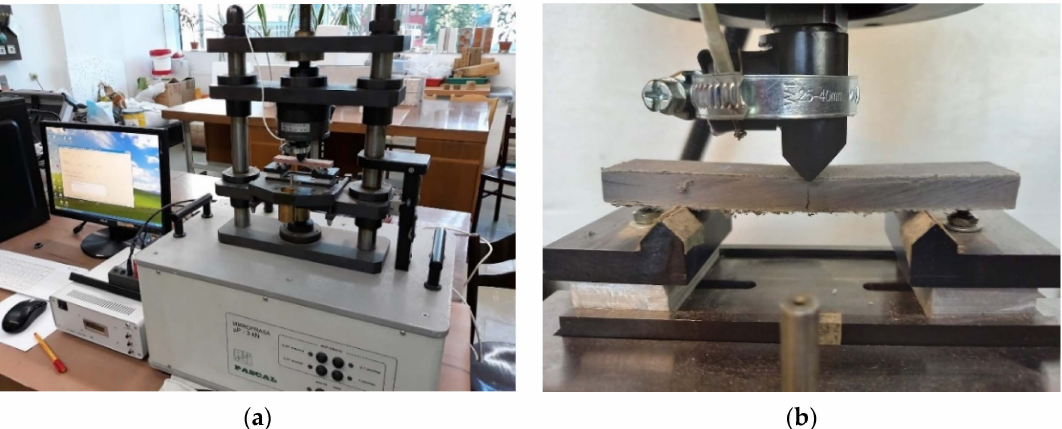
Figure 5. Test stand for acoustic emission measurements and the fibre cement board used during the test: ( a ) view of the testing machine; ( b ) view of the specimen during its destruction.